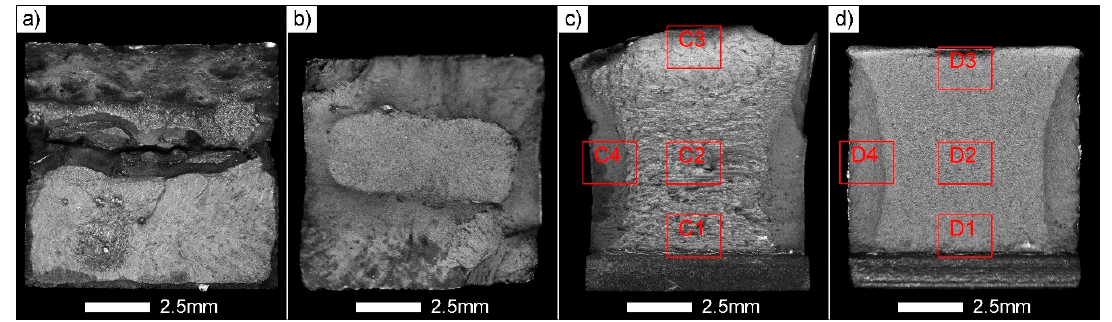
Figure 16. Macroscopic images of fracture surfaces of selected Hardox 600 joints listed in Table 5: ( a ) AW-UTS-3; ( b ) HT-UTS-1; ( c ) AW-KCV-3; and ( d ) HT-KCV-1; C1/D1: zone below the notch; C2/D2: central zone of the fracture; C3/D3: final fracture zone; C4/D4: side zone of the fracture. Light microscopy, unetched. Metals 2017 , 7 , 349